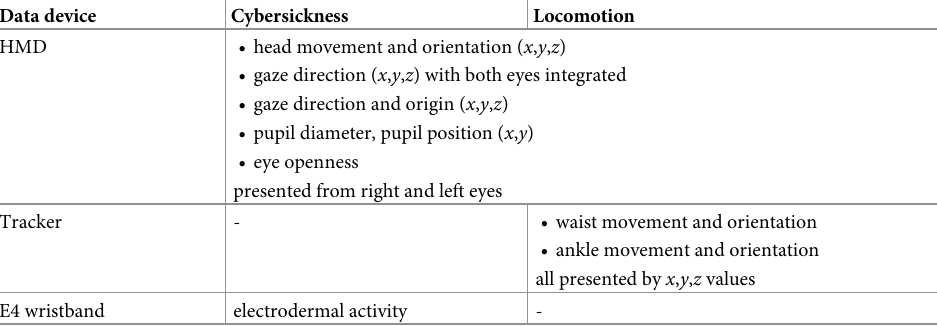
Table 1. Data features used in each study. Two studies used the same features from the HMD. The physiological sen- sor was used in the cybersickness study, and the features from the tracker were used in the locomotion